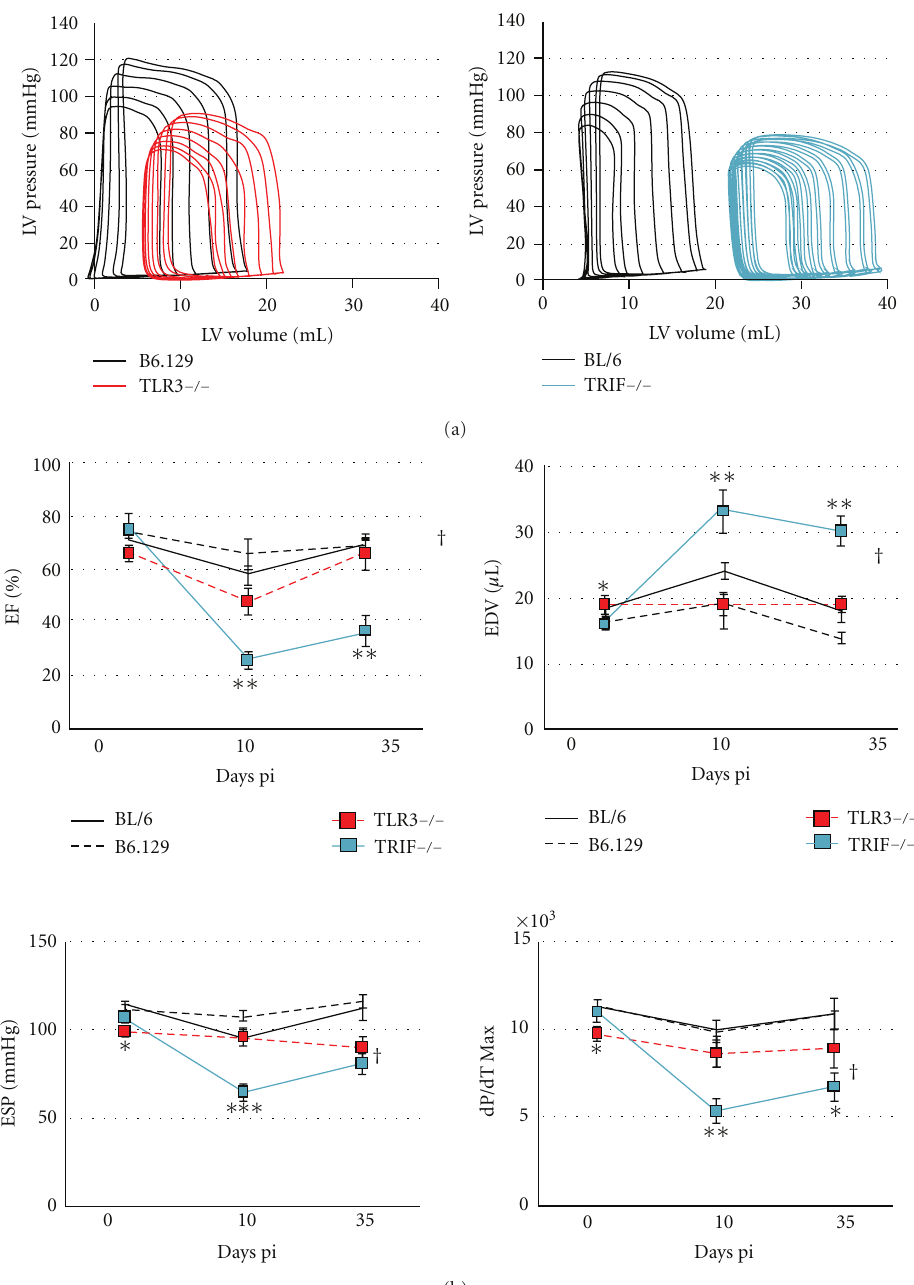
Figure 5: Cardiac function di ff ers between TLR3 deficient (TLR3 − / − ) and TRIF − / − mice during acute and chronic CVB3 myocarditis. (a) Representative pressure-volume loops for TLR3 − / − (left) and TRIF − / − (right) hearts at day 10 pi compared to their WT controls. (b) Comparison of pressure-volume relationships of TLR3 − / − , TRIF − / − and WT mice at day 10 pi, n = 10 to 12 mice/group. Student’s t -test compares TLR3 − / − to TRIF − / − at day 0, 10 or 35 pi; ∗ : P < 0 . 05; ∗∗ : P < 0 . 01; ∗∗∗ : P < 0 . 001. ANOVA compared TLR3 − / − to TRIF − / − mice over time; † , P < 0 . 05. EF: ejection fraction; dP/dT Max (mm Hg/s) measures the peak rate of pressure rise; ESP: end systolic pressure; EDV: end diastolic